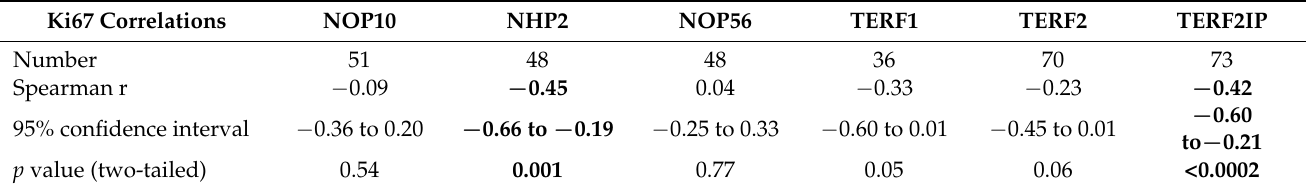
Table 2. Ki67 correlations with telomere and telomerase associated protein Quickscores for all samples.